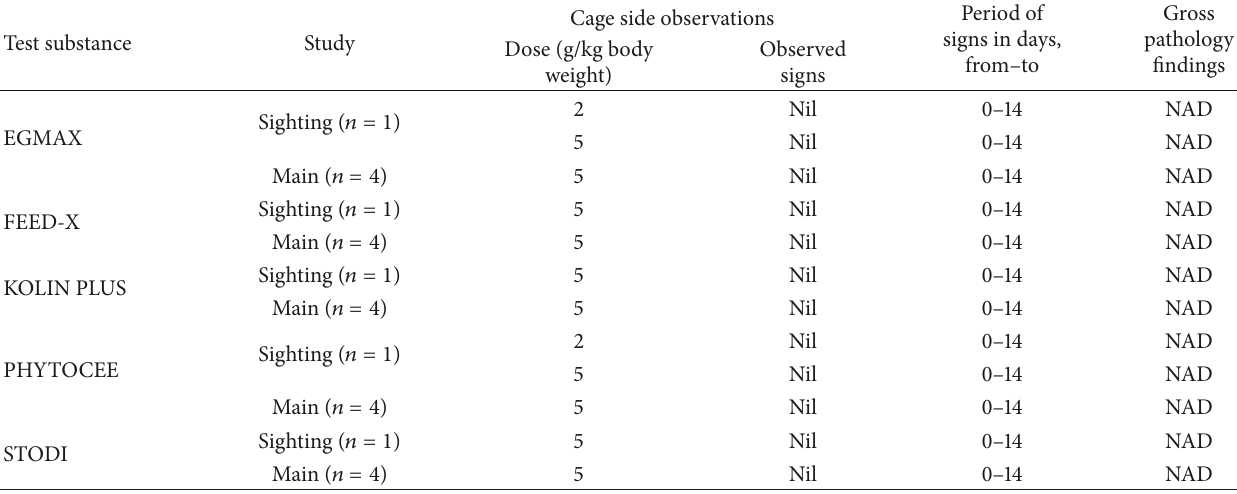
Table 7: Acute oral toxicity test results: clinical signs and gross pathology findings in rats after treatment with PFS.